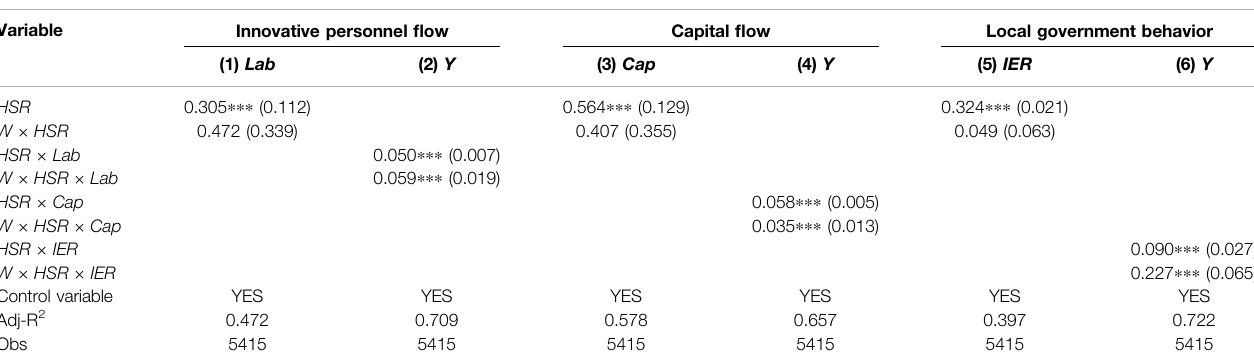
TABLE 5 | Optimal radius test